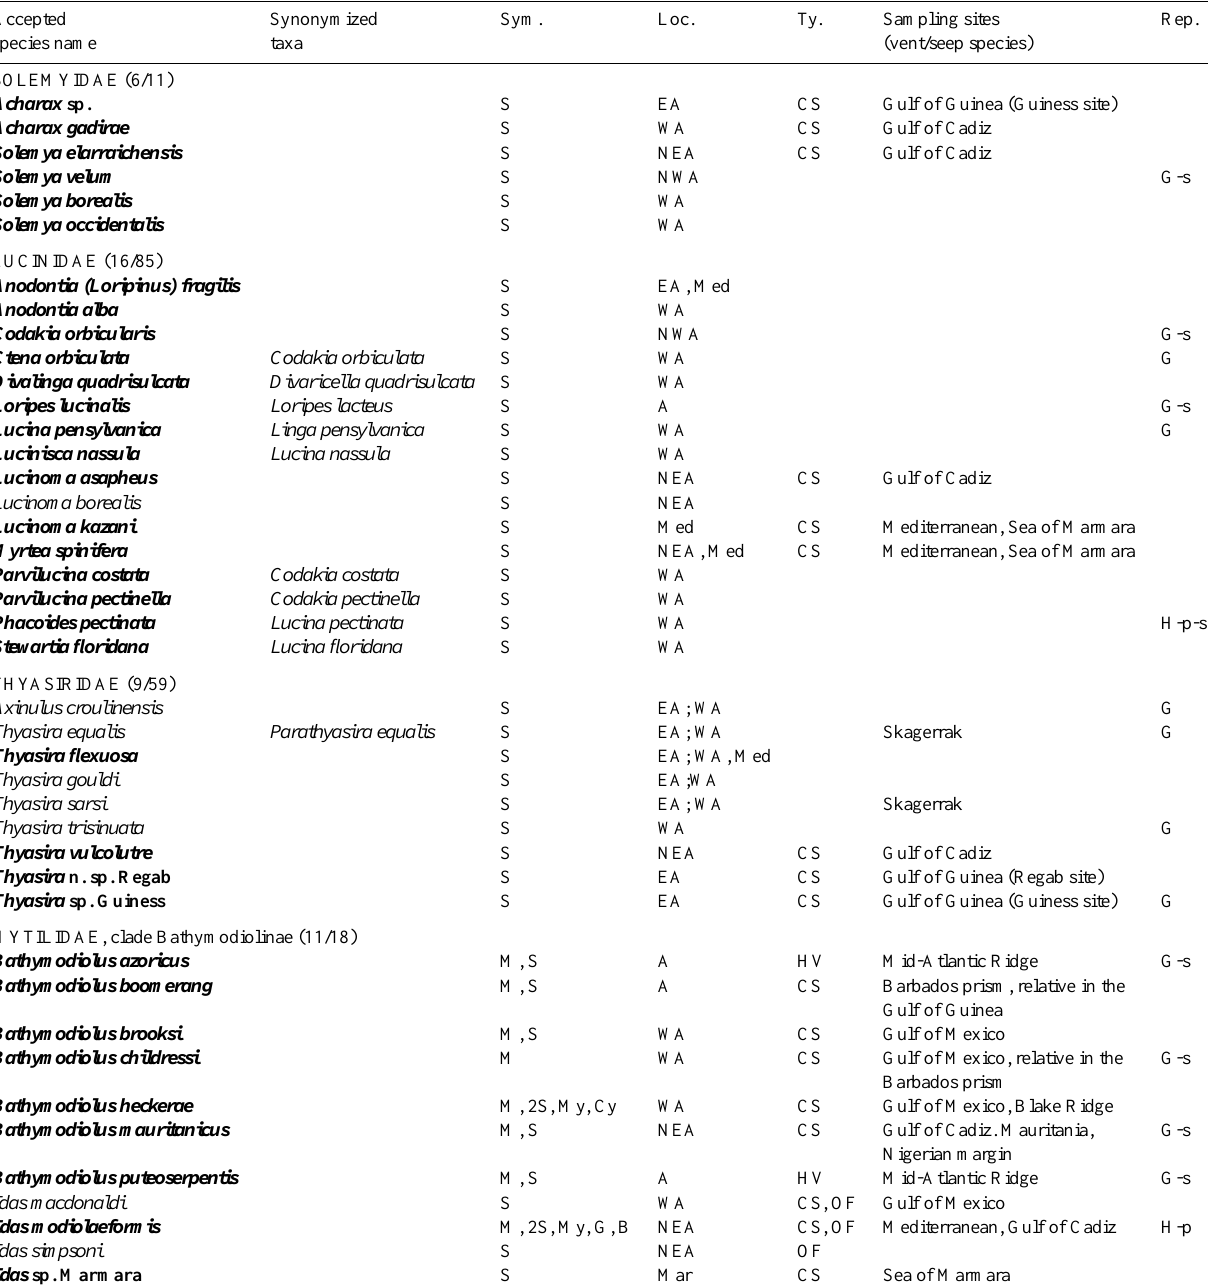
Table 1. Summary of chemosymbiotic bivalve species for which data are available regarding symbiosis in the Atlantic, Gulf of Mexico, and Mediterranean Sea. Numbers in parentheses indicate the number of species for which symbiosis is documented using electron microscopy and molecular data, possibly including in situ hybridization of symbionts (bold). Synonymized taxa, according to the World Register of Marine Species (WORMS, www.marinespecies.org), are included as many former names were in use when symbioses were initially documented, and thus appear in the tree (Fig. 2). Species within genus “ Pliocardia ” were recently ascribed to undetermined genus (Audzijonyte et al., 2012). Symbiont (Sym.) types: sulfide (S)-oxidizer, methane (M)-oxidizer, (My) methylotrophs, Bacteroidetes (B), Cycloclasticus (Cy)-related and (G) for Gammaproteobacteria unrelated to other documented symbiont groups. Location (Loc.) corresponds to north (N), south (S), east (E), west (W) Atlantic (A), and Mediterranean (Med). Type (Ty.) of chemosynthesis-based ecosystem is mentioned for deep-sea species, (CS) cold seeps, (HV) hydrothermal vents, and (OF) organic falls. A non-exhaustive list of sampling sites is provided for vent and seep species (vent and seep sites illustrated in Fig. 1). Reproduction (Rep.), when documented, is either gonochoric (G) or hermaphrodite (H)(-p then means protandric), and can be seasonal (-s). For references, see